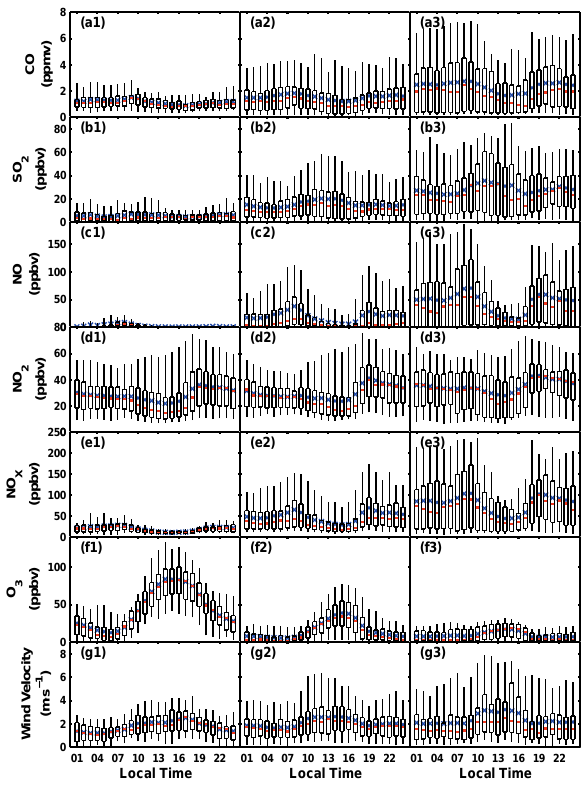
Fig. 6. Diurnal variation of CO (a) , SO 2 (b) , NO (c) , NO 2 (d) , NO x (e) and O 3 (f) mixing ratio during summer (1), fall (2) and winter (3). The blue cross represents the mean value, while the red bar stands for the median value. The black boxes and whiskers denote the 5, 25, 75 and 95th